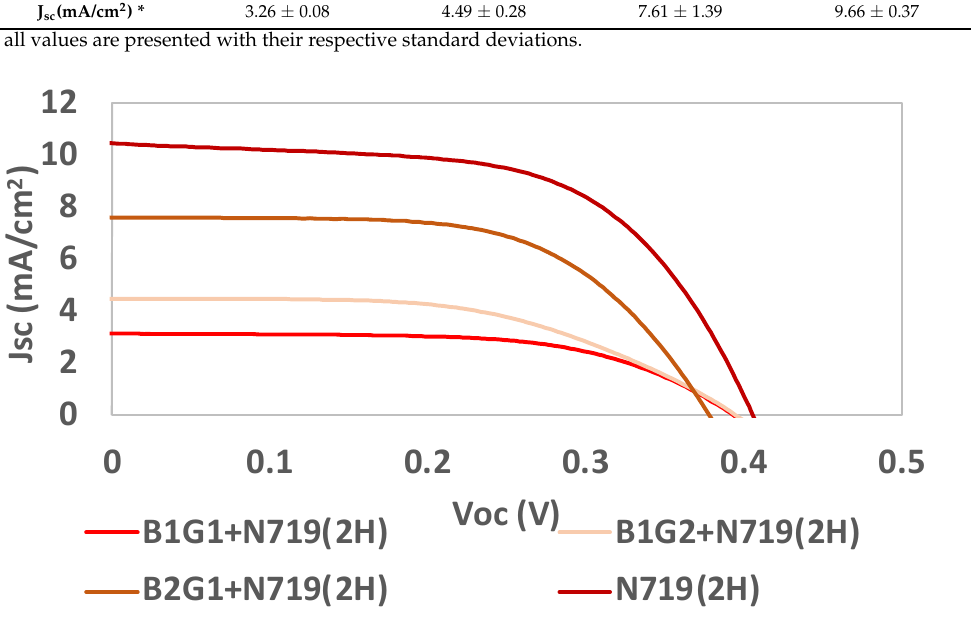
Figure 13. Photocurrent–voltage (J–V) curves of DSSCs based on the use of the COF RIO-60 as an interface between TiO 2 and the reference dye N719 for the different batches B1G1, B1G2, B2G1, and N719, all under simulated AM 1.5G illumination at 100 mW/cm 2 .